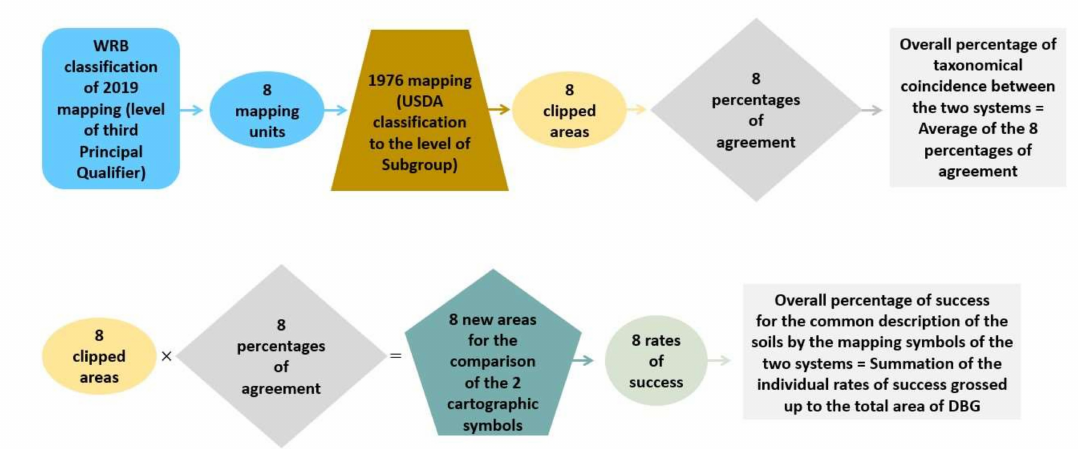
Figure 6. Schematic presentation showing the procedures for comparison of the two mapping systems. The spatial object of WRB classification fragmented into 8 mapping units according to the 8 taxonomical categories. The 8 mapping units also included all the information of the cartographic symbol of 2019 mapping. Each mapping unit was used as a clipping surface for the extraction of SMUs of 1976 mapping that contained all the information of the cartographic symbol of 1976 mapping including the USDA